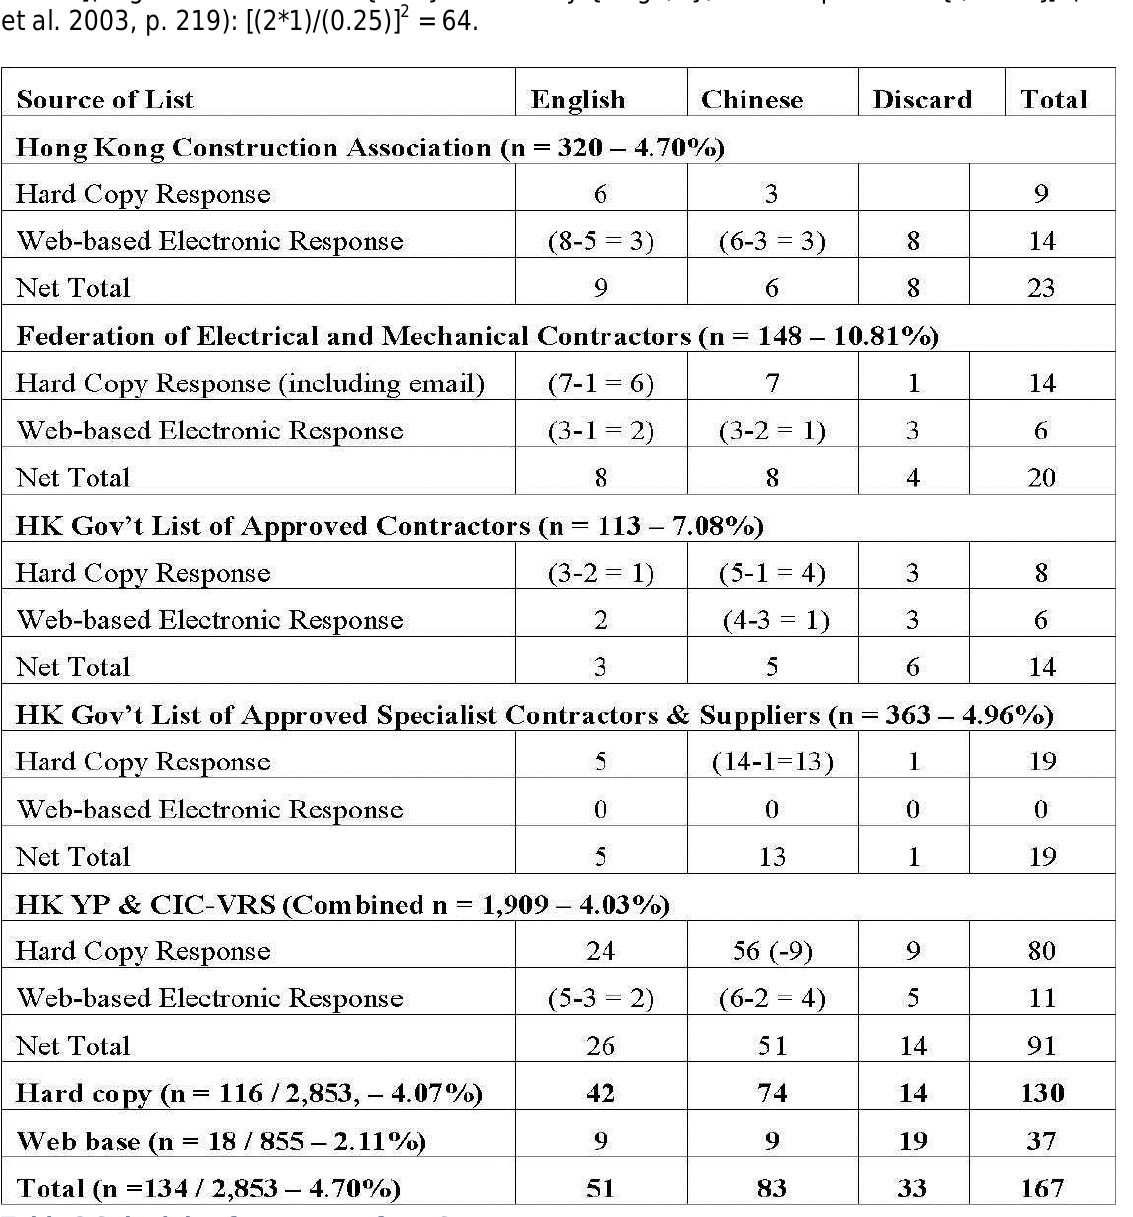
Table 3 Schedule of responses from